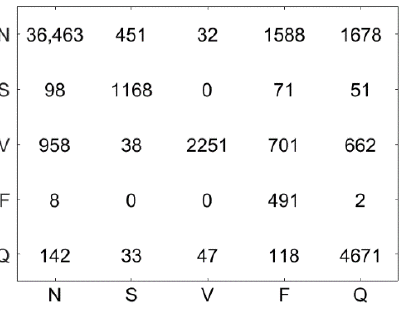
Figure 10. Confusion matrix using the LSVM